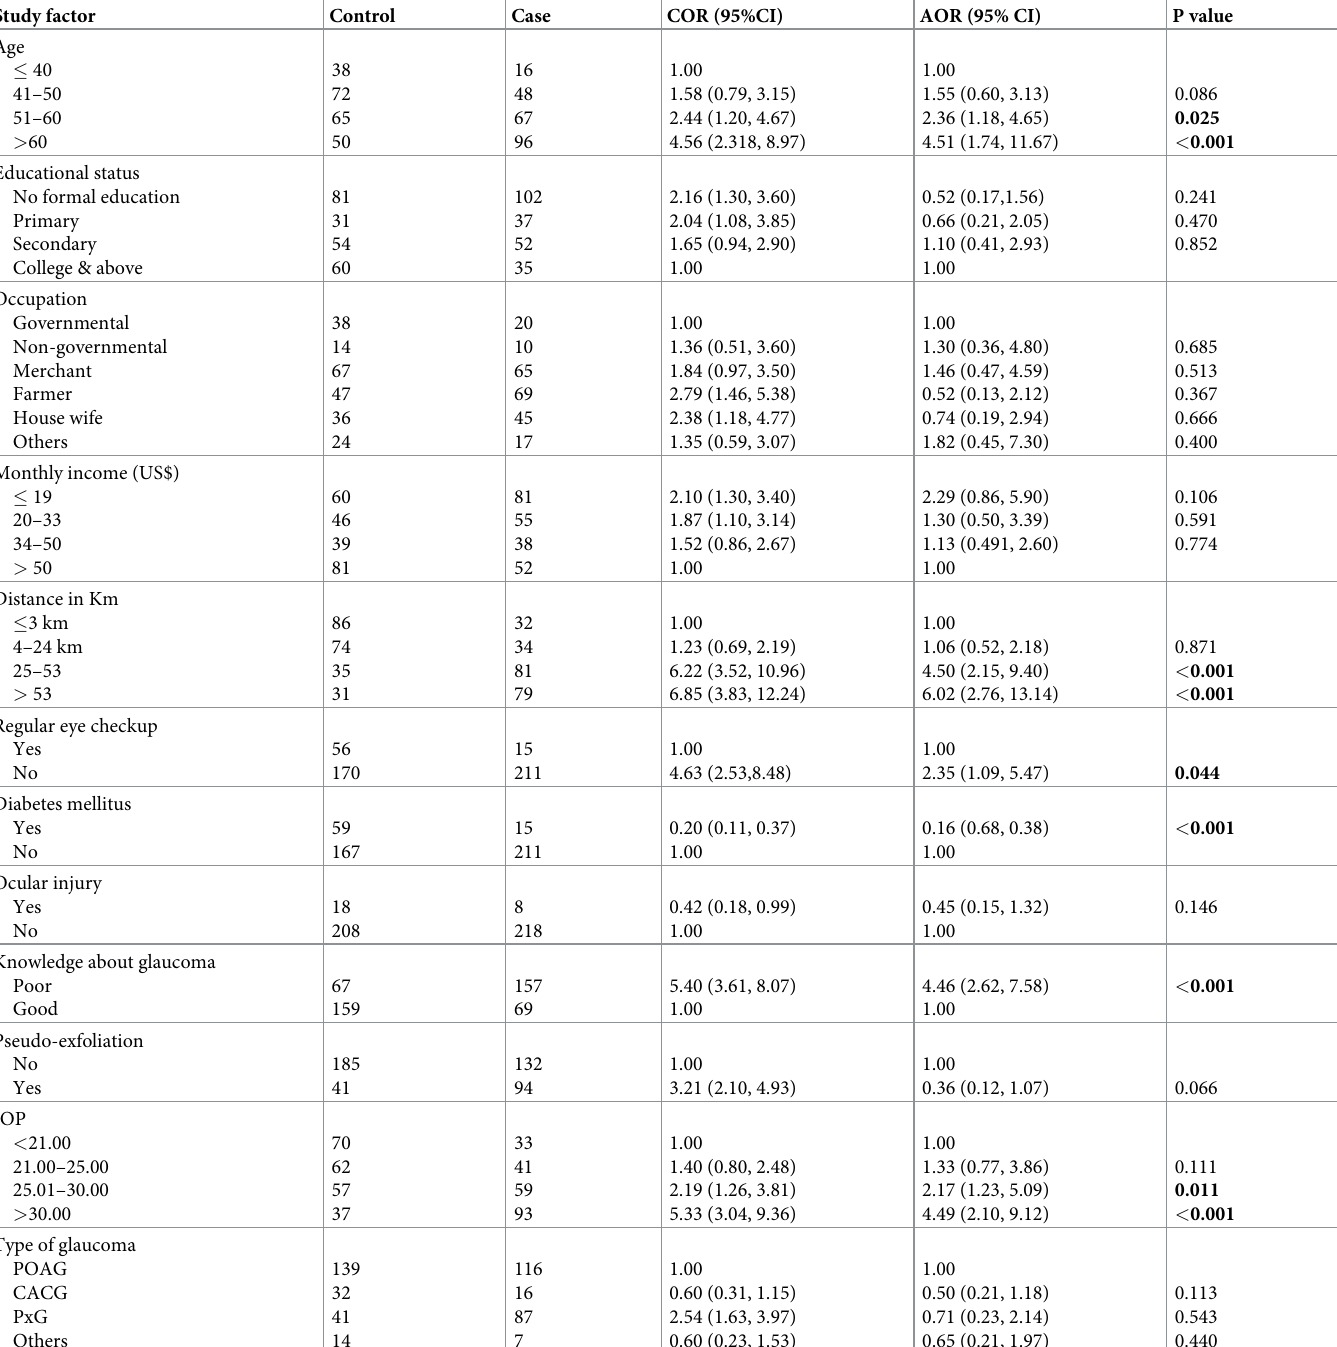
Table 3. Determinant factors associated with late presentation among adult glaucomatous patients in University of Gondar Comprehensive Specialized Hospital, Northwest Ethiopia,